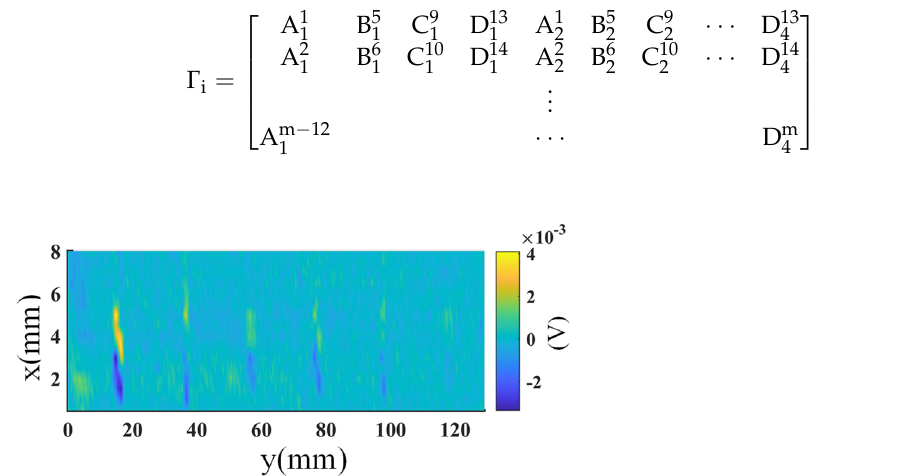
Figure 10. The resolution enhanced image is interpolated from the four images shown in Figure 8. Noise is inevitable in the experiment, which may affect the small defects identifica- tion. Therefore, the images should be processed to suppress the noise. Using the Stable Principal Component Pursuit (SPCP) algorithm by constructing local patches [38] can sup- press most noise. Figure 11 shows the flowchart of denoise. The raw images of the SD mode (S 0 ) and OD mode (O 0 ) are processed separately. Before using patch-image, a 2D median is applied to the raw image to reduce noise. Then, a series of patch-image blocks are obtained using a sliding window from the top left to the bottom right of the images, the sizes of which are 10 pixels × 10 pixels, and the step is 3. The construction matrix E is obtained by changing the position of the sliding window to F. Assuming the noise is in- dependent and identically distributed, the patch-image model conforms to (7).